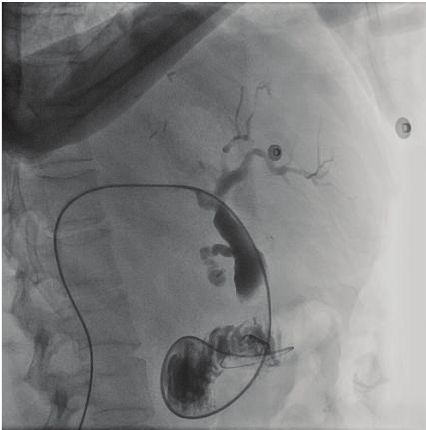
Figure 5: Percutaneous transhepatic cholangiography showed dif- fuse dilation of the biliary tree and the guide wire passing through the major papilla just adjacent to the Bear Claw